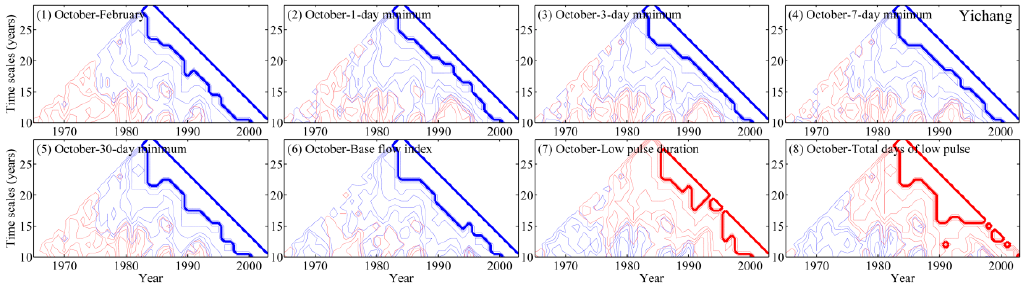
Figure 8. Coherency between monthly flow in October and low ‐ flow relevant indicators at the Yichang station.